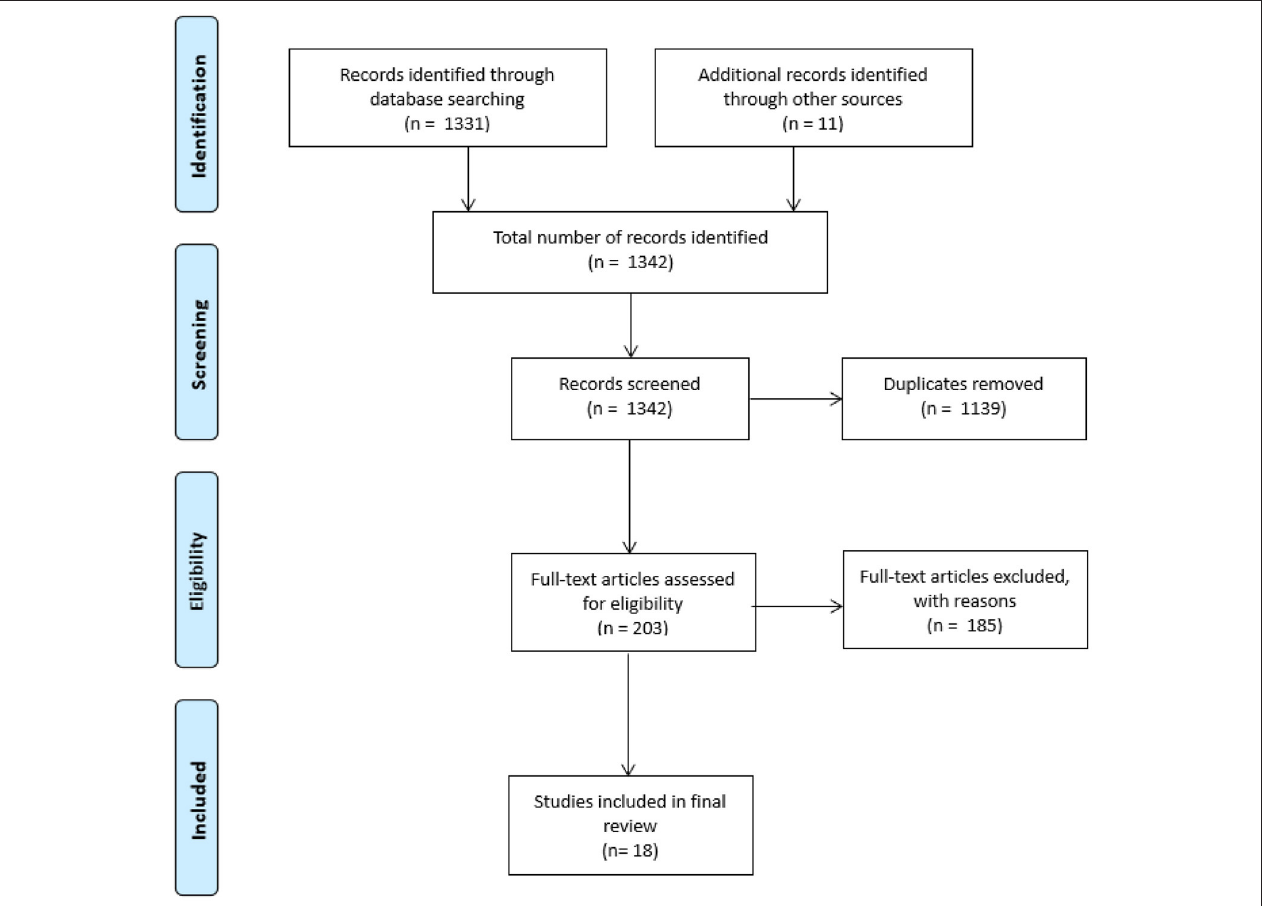
FIGURE 1 | Flow chart of the scoping review